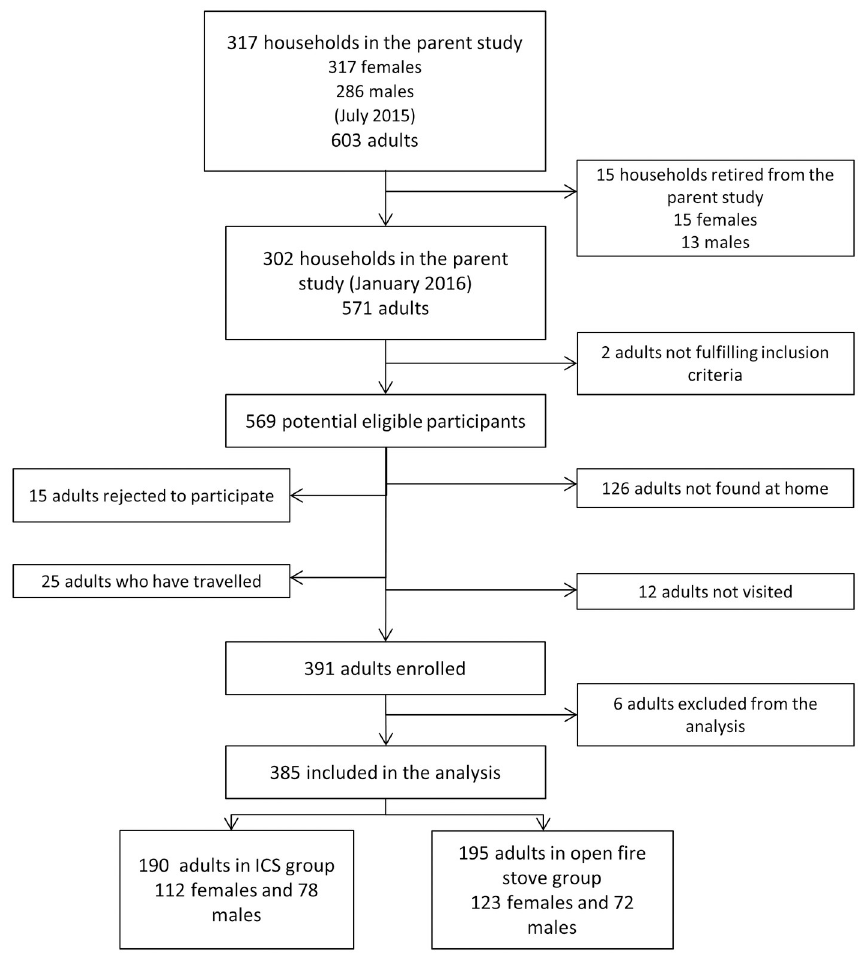
Fig 1. Flowchart of study participants of the provinces of San Marcos and Cajabamba, Cajamarca-Peru. ICS: Improved cookstoves.